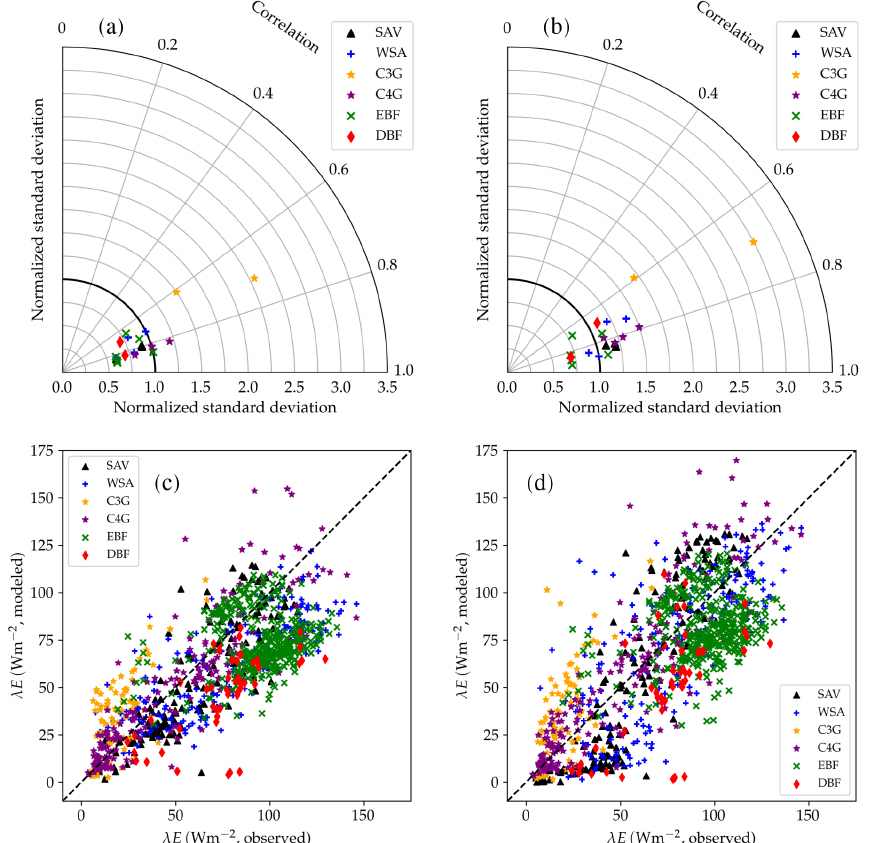
Figure 14. Performance of the CLM/BB (a, c) and CLM/Med (b, d) runs for latent heat flux. The Taylor diagram shows statistical metrics calculated from hourly observed and simulated fluxes. The scatter plots show a direct comparison of observed and modelled monthly- averaged fluxes. The different symbols refer to different land cover types: SAV, WSA, C3G, C4G, EBF, and